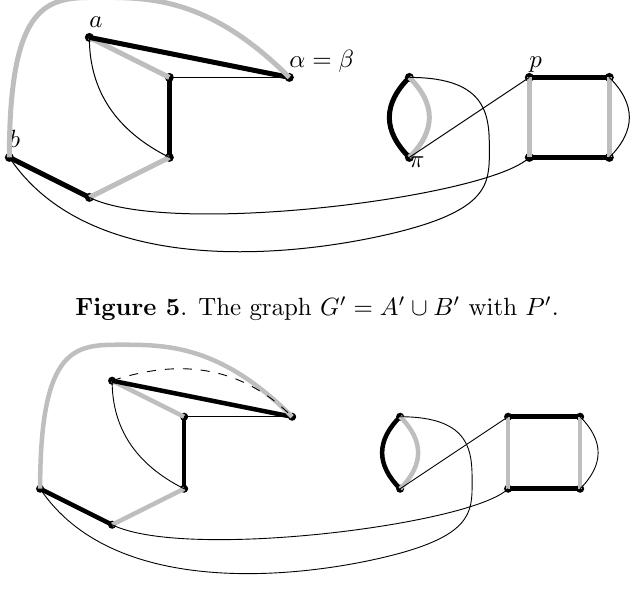
Figure 6 . The graph G 0 = A 0 [ B 0 with P 0 and a (cid:12)rst choice of edge for Q 0 .